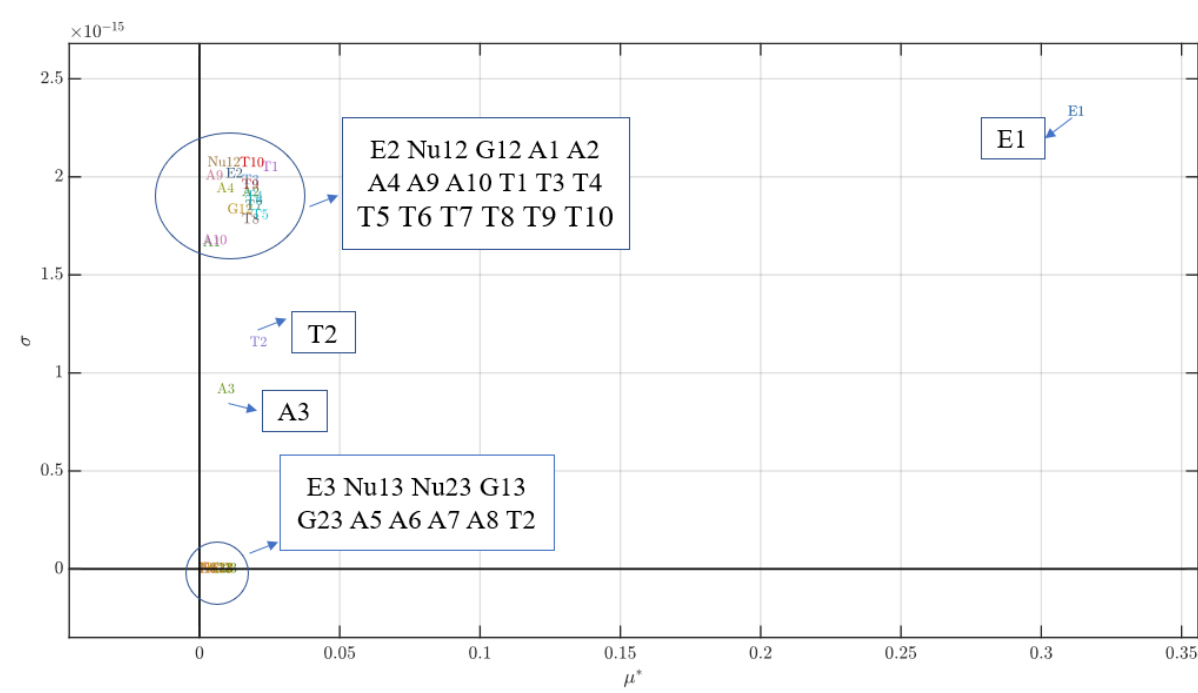
Figure 9. Global sensitivity analysis results using the Morris method. The values of µ * for all random variables except E1 are shown in Figure 10, where it can be seen that E2, G12, A2, T1, T2, T3, T4, T5, T6, T7, T8, T9, T10 are the most influential random variables for the variation in output apart from E1. This is in agreement with the results of the Sobol’ indices. The results of g the lobal sensitivity analysis using the Morris method are consistent with those obtained using the Sobol’ indices. The correctness of the global sensitivity analysis results is thus